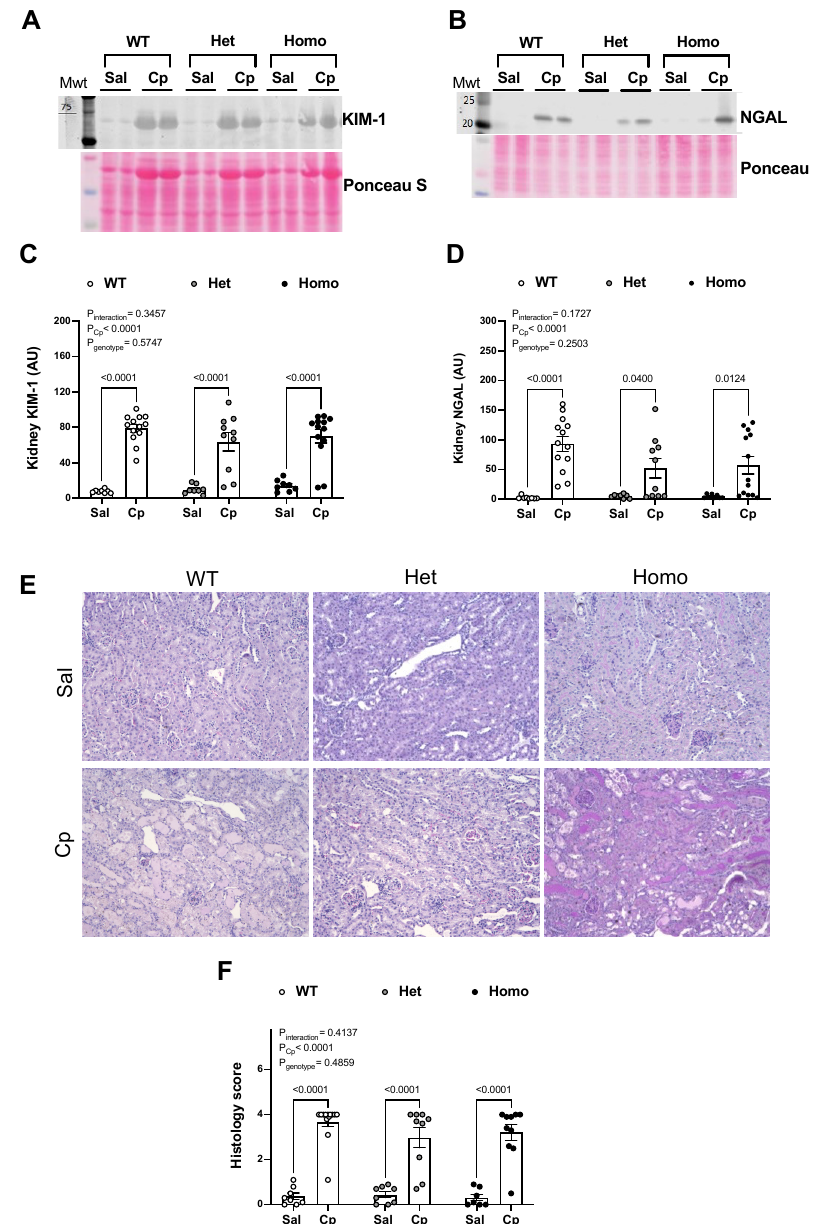
Figure 3. Cisplatin-induced rise in kidney levels and histological indexes of renal tubular injury. Representative images for Western blots on total kidney lysates for kidney injury molecule 1 (KIM-1, ( A )) and neutrophil gelatinase-associated lipocalin (NGAL, ( B )) measured on day 3 after cisplatin (Cp, 20 mg/kg) or saline injections in male mice, homozygous (homo) and heterozygous (het) knockout for GPER1 gene, and wild-type (WT) littermates. Densitometric values (AU, arbitrary units) for kidney levels of KIM-1 ( C ) and NGAL ( D ) were normalized to the Ponceau S staining. Representative histological images of periodic acid-Schiff (PAS)-stained kidney sections from male homo, het, and WT mice on day 3 after Cp or saline injections are shown ( E ). Scale bar = 200 µ m. Quantification using a semiquantitative scale (0–4) of indexes of renal injury is demonstrated ( F ). Data are presented as mean ± SEM (n = 7–13 mice/group). Statistical comparisons were performed by two-way ANOVA with Sidak’s post hoc test for multiple comparisons ( C , D , F ). p values for ANOVA and post hoc test results are displayed on the figures. AU, arbitrary units; Cp, cisplatin; Het: heterozygous knockout for GPER1 gene; Homo, homozygous knockout for GPER1 gene; KIM-1, kidney injury molecule 1; NGAL, neutrophil gelatinase-associated lipocalin; PAS, periodic acid Schiff; Sal, saline; WT,